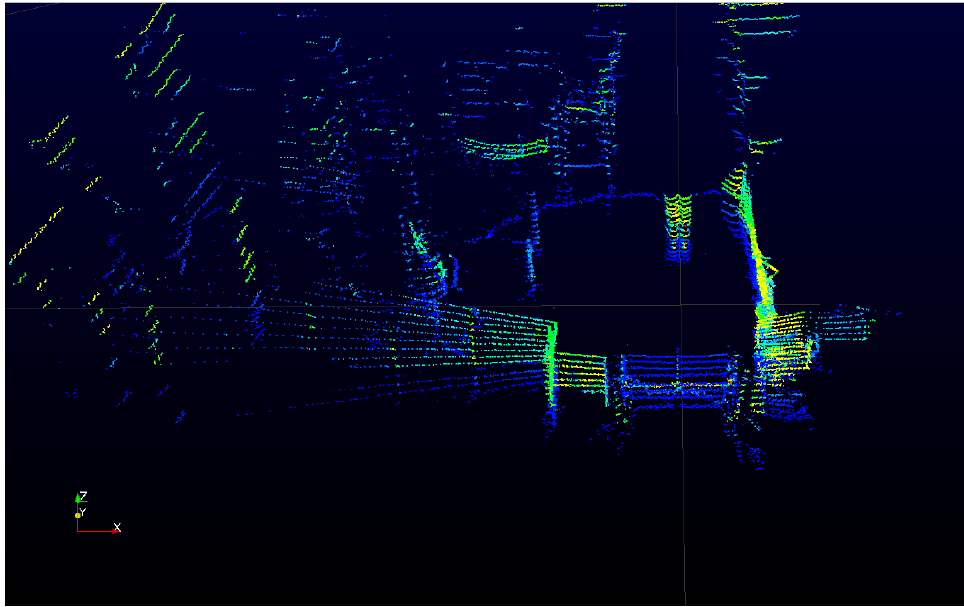
Figure 4. Live-captured 3D LiDAR data obtained from the VeloView software in an office setup.